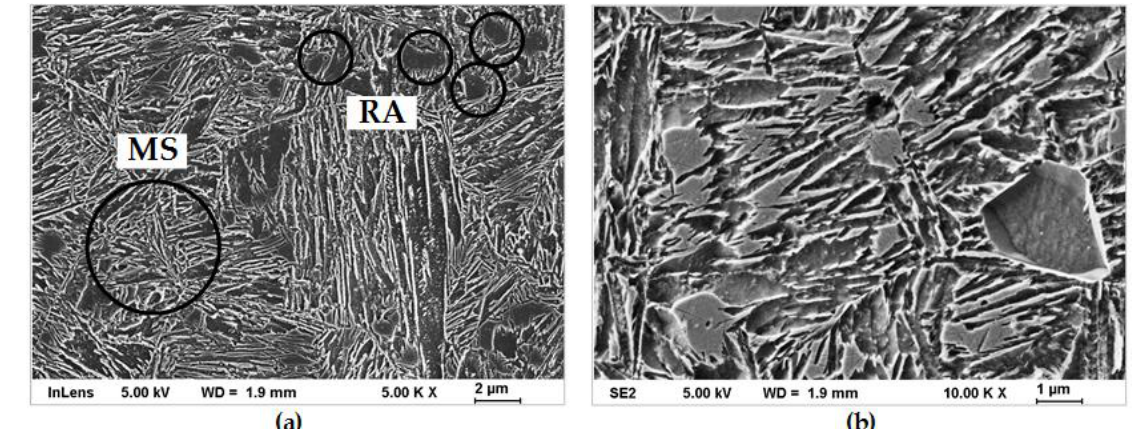
Figure 5. ( a ) Scanning electron microscopic image of QP2; ( b ) detail QP2.